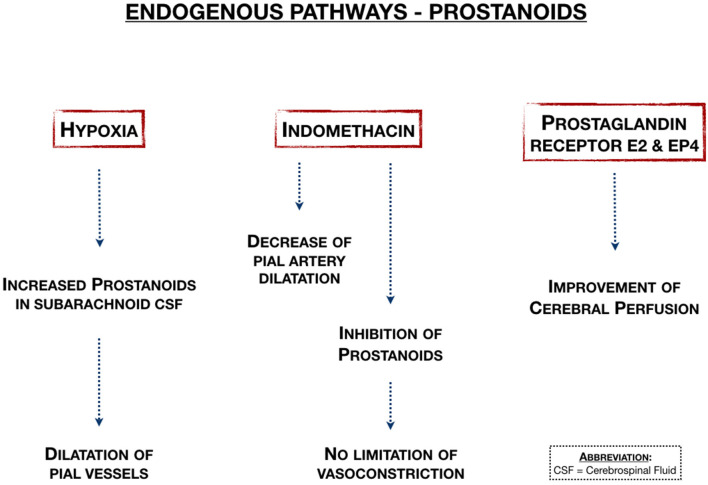
Endogenous pathways associated with prostanoids (17, 18, 43, 46).